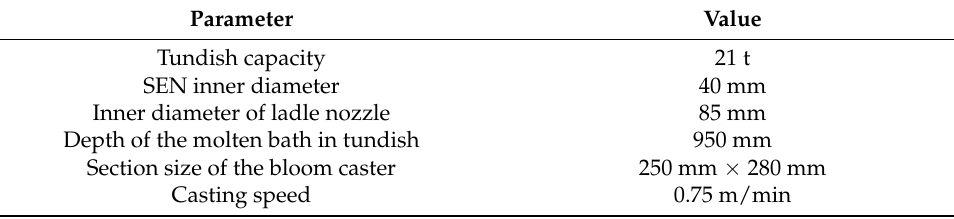
Figure 1. Schematic diagram of the prototype tundish ( a ) and flow control device ( b ), unit: mm. Table 2. Process parameters for the continuous casting of C70S6 steel.